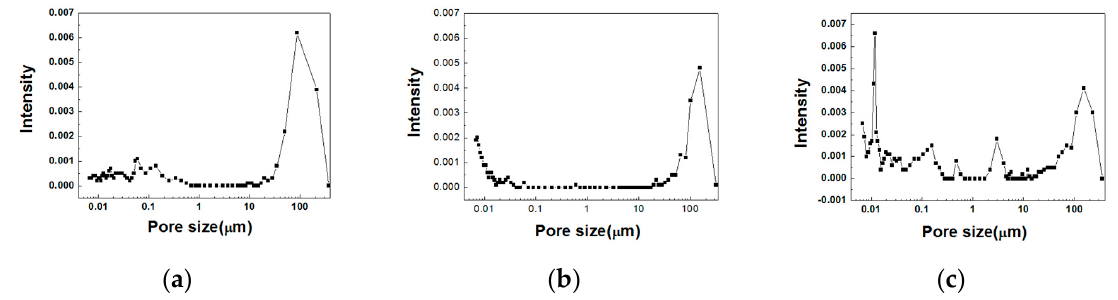
Figure 10. Mercury intrusion porosimetry (MIP) measurements of samples at a firing start temperature of 300 °C: ( a ) 210 min, ( b ) 240 min, and ( c ) 270 min.